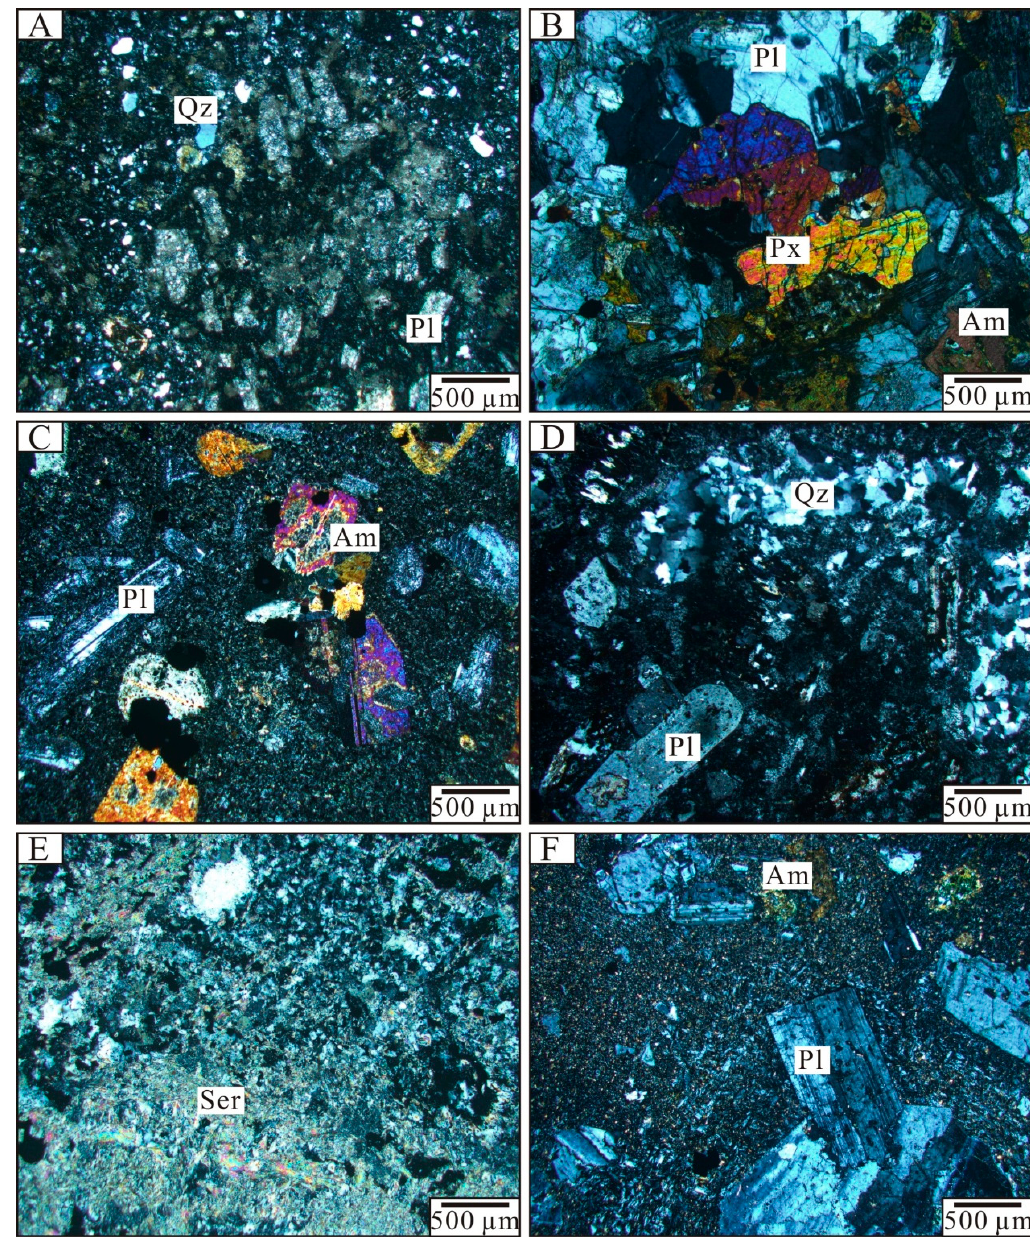
Figure 3. ( A ) Photomicrograph of the pyroclastic rocks of the Qingshan Group; ( B ) Photomicrograph of the pyroxene diorite; ( C ) Photomicrograph of the andesitic porphyry; ( D ) Photomicrograph of the quartz diorite porphyry; ( E ) Photomicrograph of the sericitized quartz diorite porphyry; and ( F ) Photomicrograph of the diorite porphyry. Abbreviations: Qz (quartz); Pl (plagioclase); Px (pyroxene); Am (amphibole); Ser (sericite).